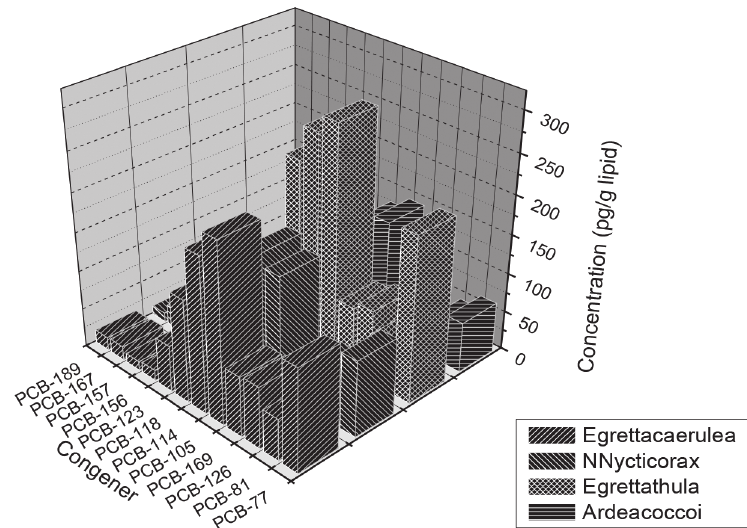
Figure 2 - Concentrations of PCB Congeners in avian species studied (pg/g lipid).